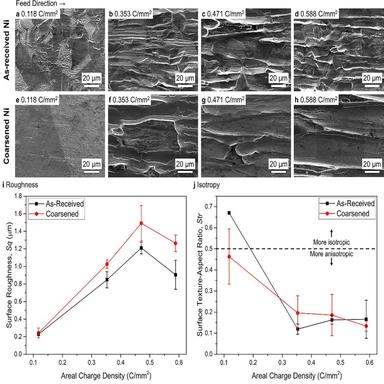
SE micrographs of each surface layer in the as-received (a-d), and coarsened (e-h) samples. Surface roughness, Sq, and surface texture-aspect, Str (isotropy), follow identical trends in both samples. Striation wavelength appears greater in the coarsened sample. Error bars are the standard deviation from the mean of three areas of surface.